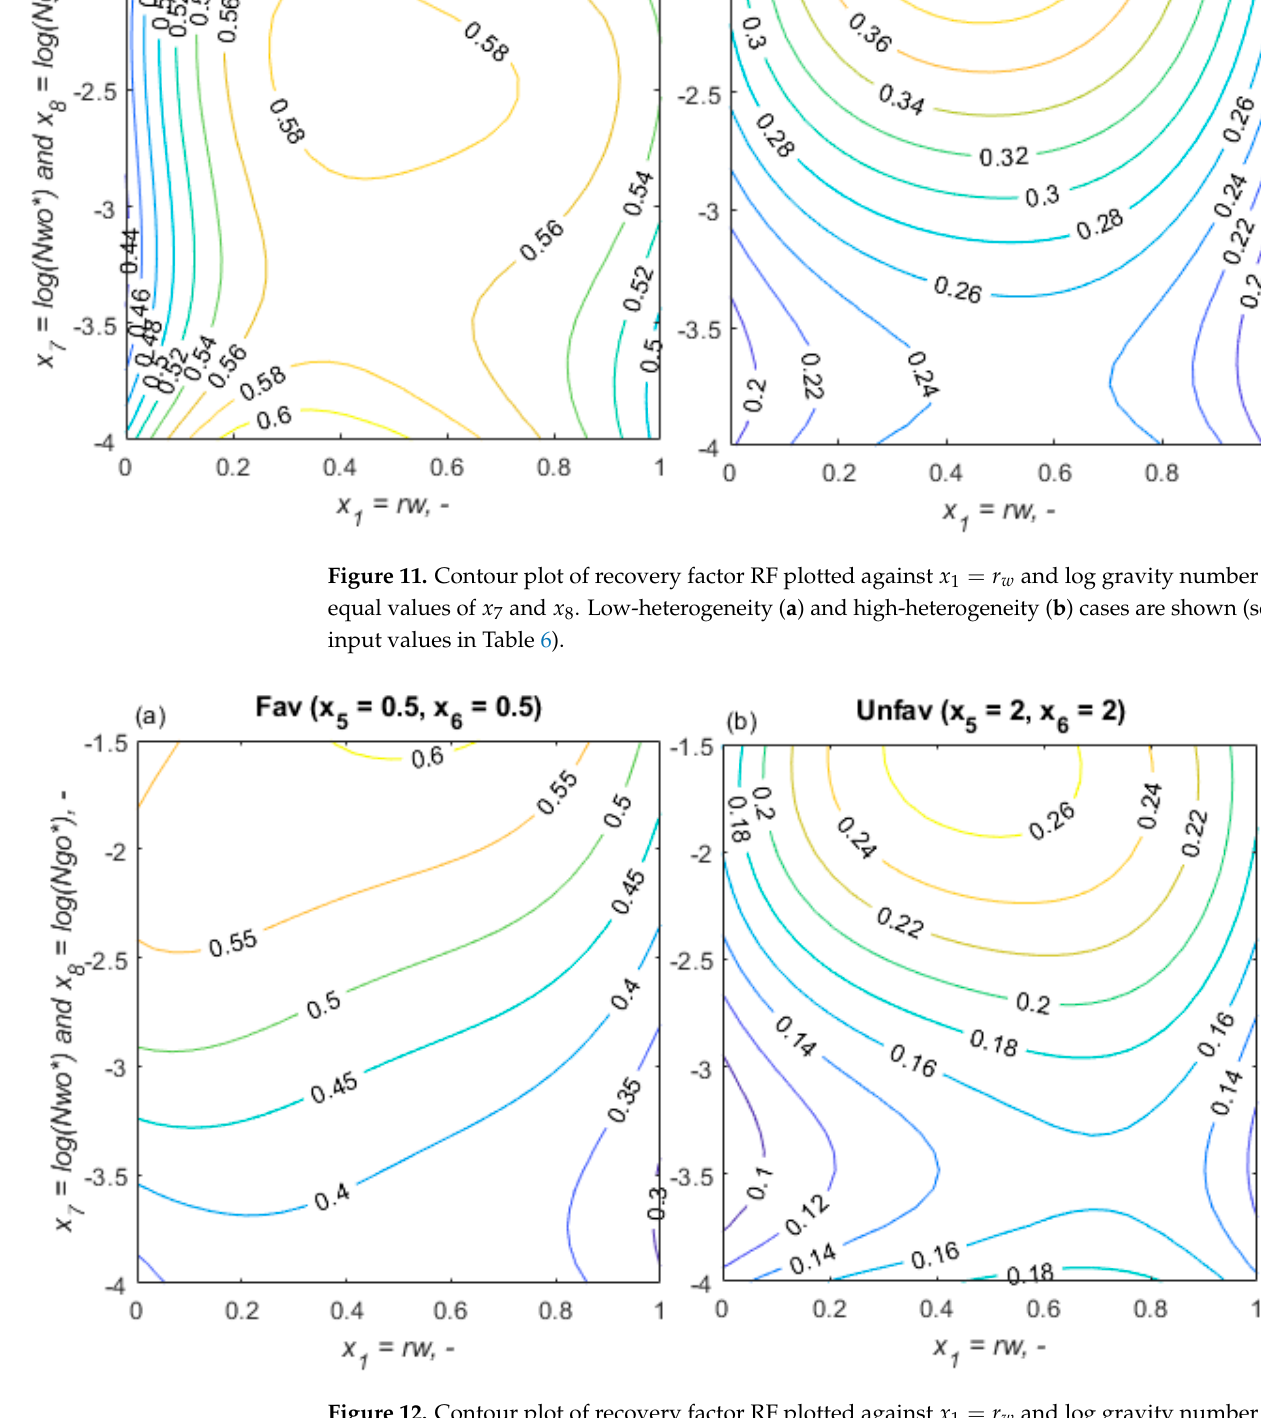
Figure 13. Contour plot of recovery factor RF plotted against 𝑥 (cid:2869) (cid:3404) 𝑟 (cid:3050) and log gravity number with equal values of 𝑥 (cid:2875) and 𝑥 (cid:2876) . Low ‐ ( a ) and high ‐ ( b ) hysteresis cases are presented (see all input values in Table 6).